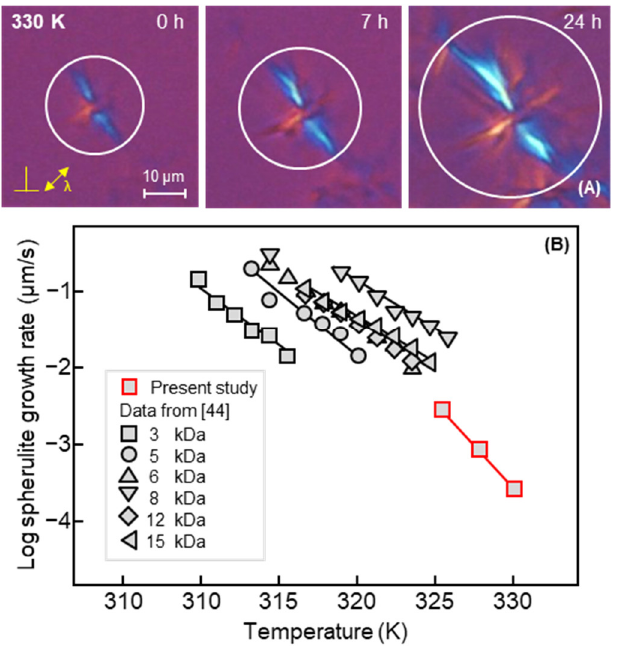
Figure 3. POM images of a PCL spherulite growing at 330 K, collected at the indicated times, serving for estimating the crystal growth rate ( A ). Note that time ‘0 h’ represents the time when the system reached the growth-temperature. The polarizer and analyzer directions as well as the orientation of the long axis of the optic indicatrix of the inserted λ-plate (n γ ) are indicated in the left image. Spherulite growth rate of PCL as function of temperature ( B ). Data used for comparison are taken from [44], with permission from John Wiley and Sons, 2007. Note that data of the present work were measured triplicate, with the error bar smaller than the symbol size.